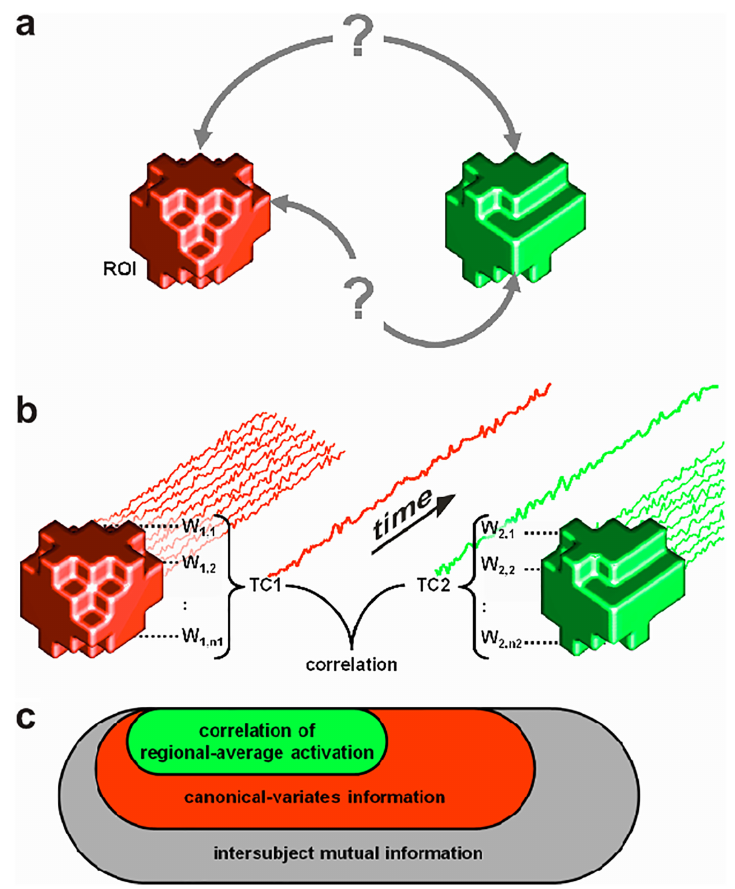
Figure 2 . Measuring shared information in corresponding functional regions of two subjects with canonical correlation analysis. (a) Given spatiotemporal brain-activity patterns in functionally corresponding brain regions in two subjects (red, green), it is dif fi cult to relate the activity patterns because the fi ne-grained spatial layout of the neuronal patterns might not match up in a common brain space and, more fundamentally, the spatial layout might be unique to each subject like a fi nger print. (b) Canonical correlation analysis fi nds weights for each response channel (e.g. voxel) in each subject, such that the correlation between the weighted-average time courses is maximized. This “ fi rst canonical correlation ” provides a linear fi rst approximation to the information shared between the regions. (c) Canonical-variates information (red) is a superset of regional-average correlation information (green) and a subset of the total mutual information (gray) between the corresponding brain regions in the two